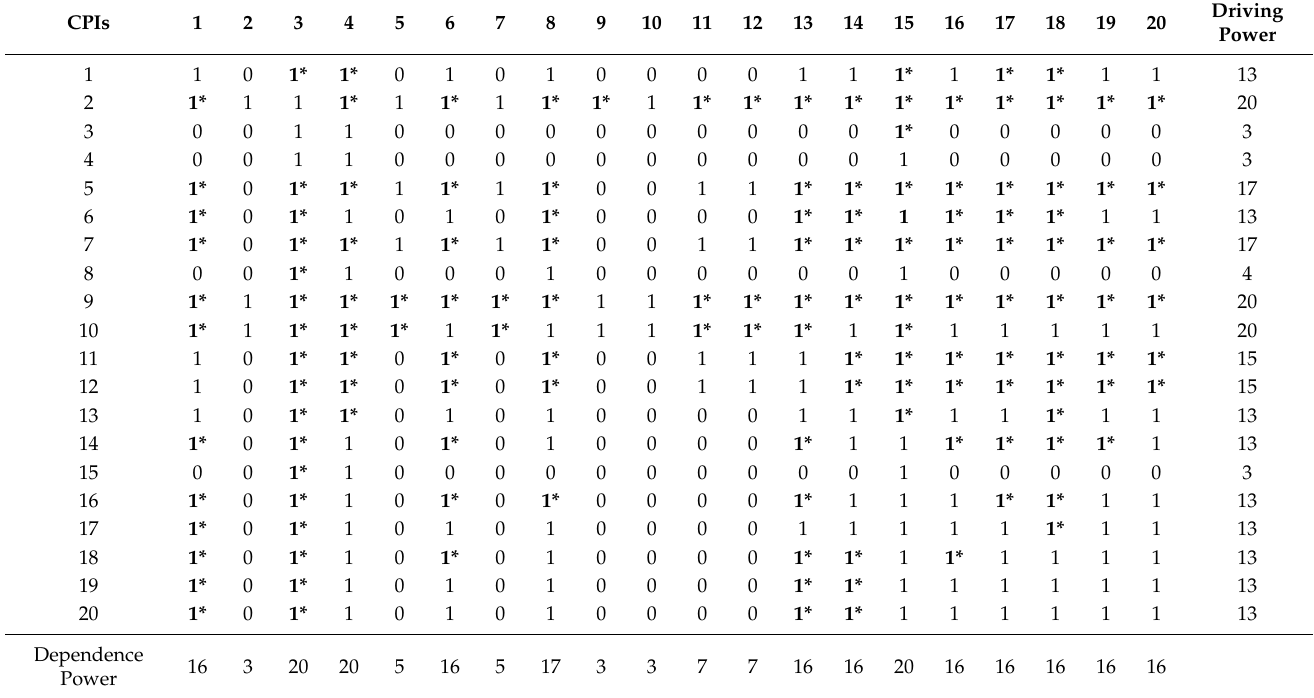
Table 3. Final Reachability